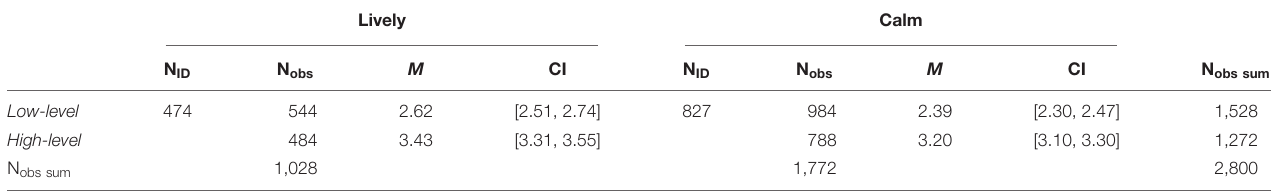
TABLE 3 | Frequencies of observations and estimated marginal means for Annoyance judgments, differentiated by the Liveliness of the living environment. Lively